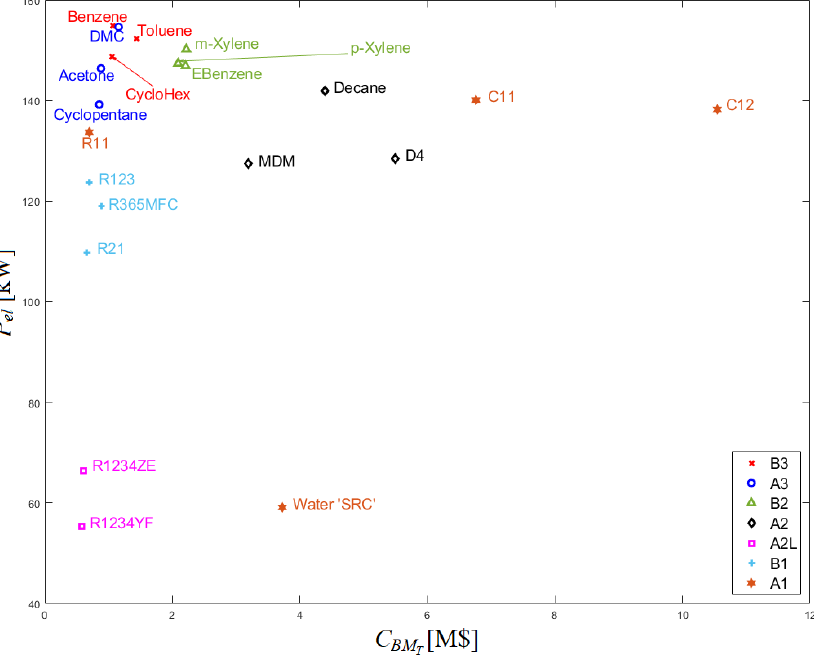
Figure 7. Net output power versus plant cost of the best 3 fluids of each safety category in the case of oil thermal